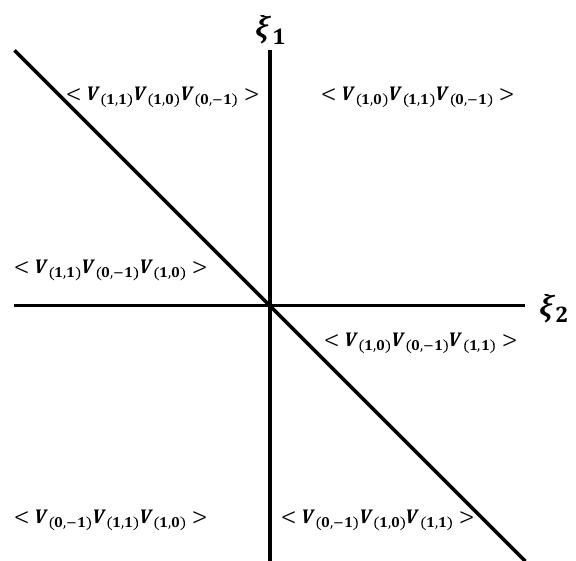
Figure 7 . This (cid:12)gure illustrates the six distinct chambers in FI space. Each chamber corresponds to a speci(cid:12)c ordering of the monopole operators V